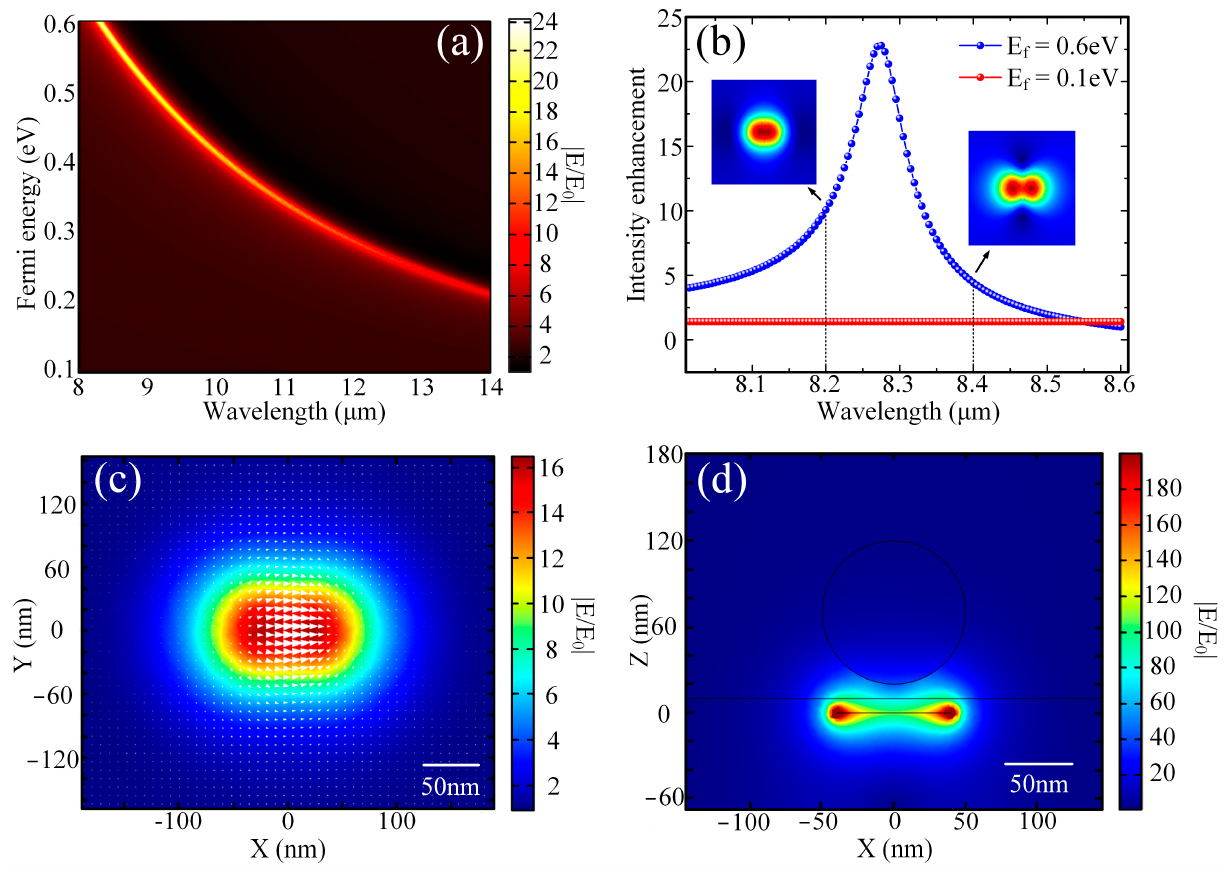
Figure 2. ( a ) The normalized intensity enhancement map under different Fermi energy and incident wavelengths. ( b ) The normalized intensity enhancement under different Fermi energy (E f = 0.1 eV, E f = 0.6 eV), and corresponding simulated amplitude distribution. ( c ) Simulated amplitude distri- bution in the 50 nm x-y plane above the graphene disc. The arrow (white) indicates the direction of the current. ( d ) Simulated amplitude distribution in the x-z plane after the introduction of the nanopar- ticle.